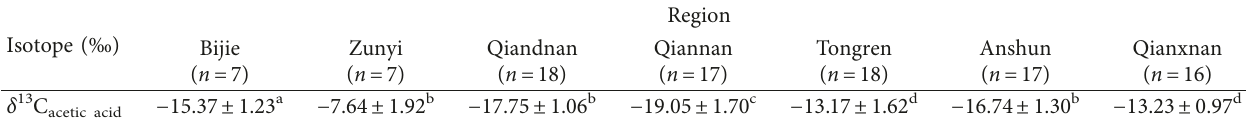
Table 1: The mean ± standard error value of the carbon stable isotope of acetic acid of sauce-flavor baijiu from seven different origins (unit: ‰).